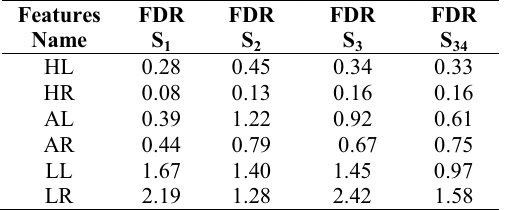
Table 2. FDR value of feature point using polygon area